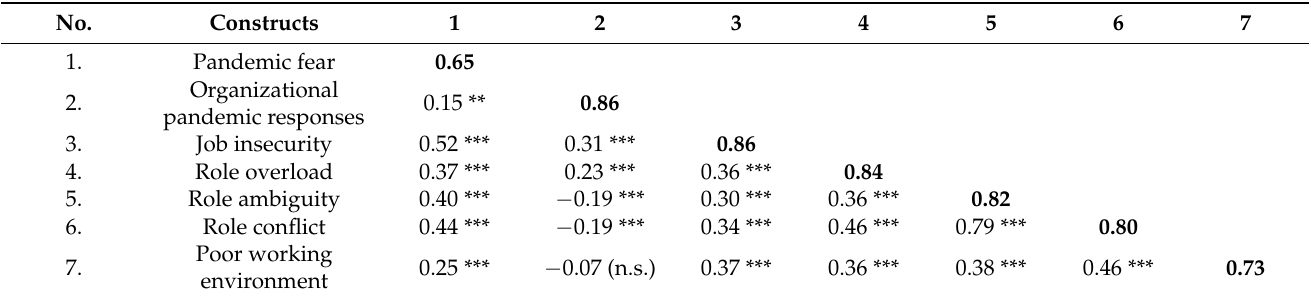
Table 5. Results of discriminant validity.